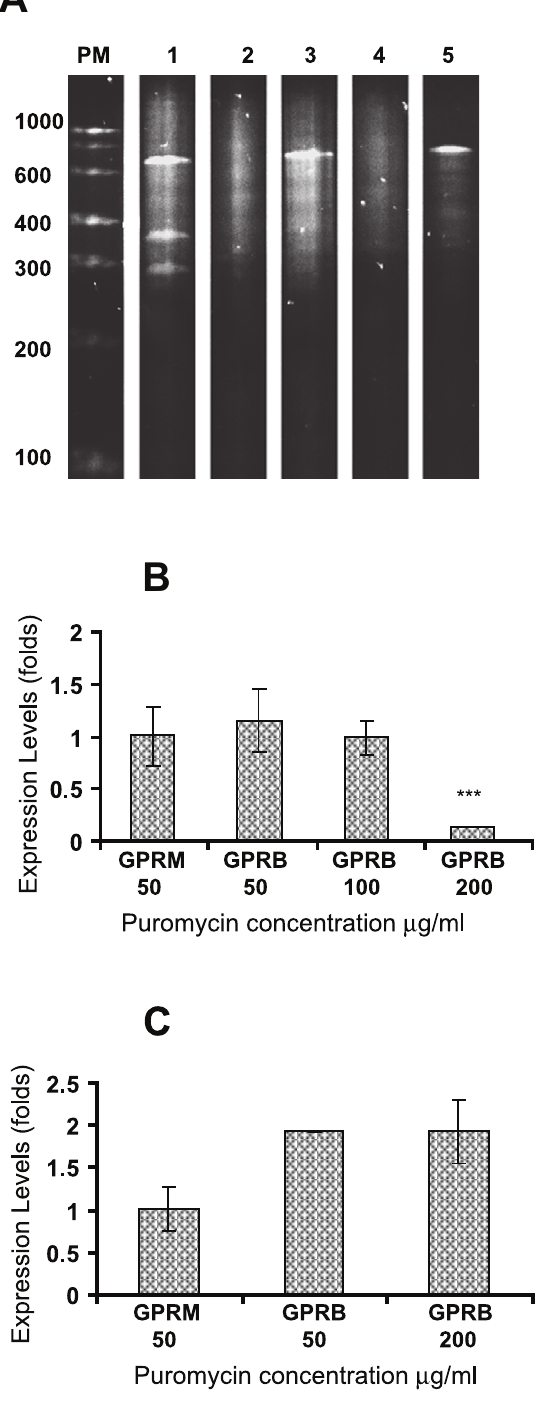
Figure 9. Rab11 ribozyme activity invitro and invivo . ( A ) ‘‘ In vitro ’’ cleavage of rab11 mRNA fragment (RAF, 651 nt) by pC631pac- Rab11B and pC631pac-Rab11M. The product was analyzed on 7% PAGE containing 7 M urea and stained with ethidium bromide. Lane 1 is pC631pac-Rab11B plus RAF. Lane 2 is pC631pac-Rab11B. Lane 3 is pC631pac-Rab11M plus RAF. Lane 4 is pC631pac-Rab11M. Lane 5 is RAF. ( B ) Total RNA from cultures of Giardia transfected with pC631pac- Rab11B (GPRB) and pC631pac-Rab11M (GPRM) selected in 50, 100 and 200 m g ml 2 1 puromycin, was isolated and the expression of rab11 ( p , 0.001) was analyzed by relative-quantitative RT-PCR. ( C )